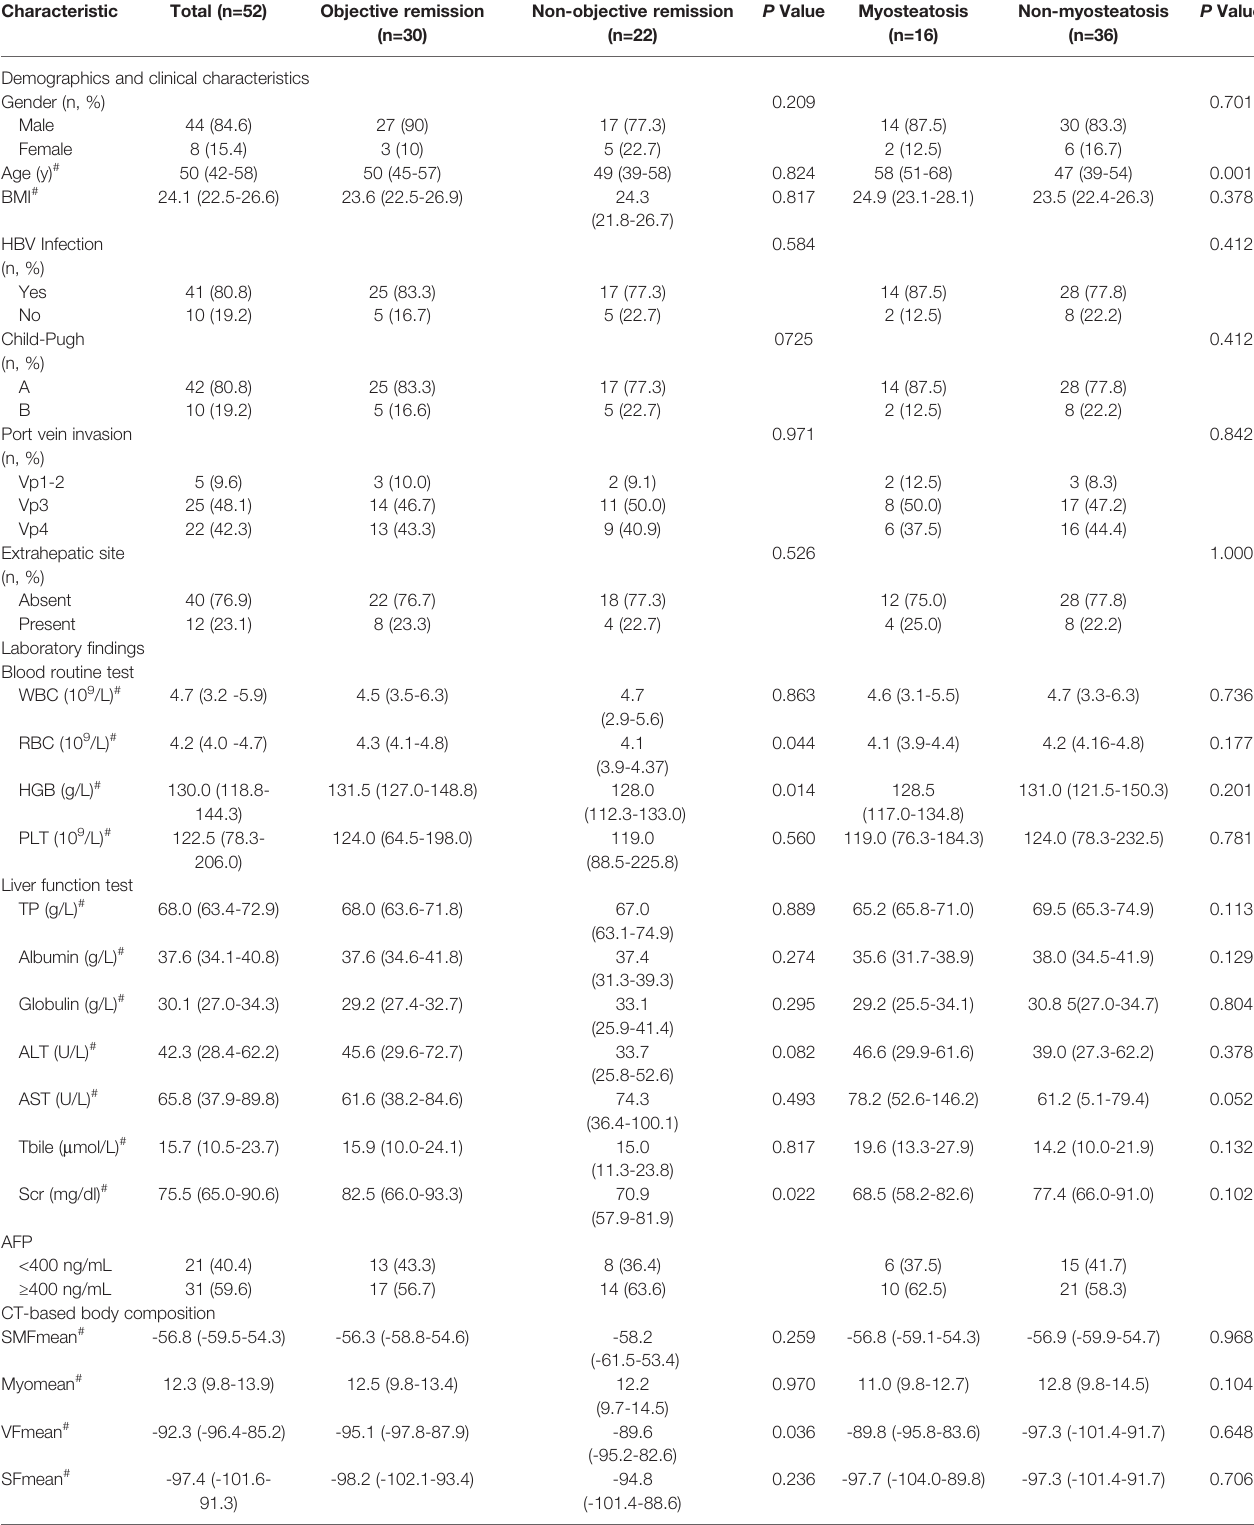
TABLE 1 | Demographic, clinical, laboratory, pathologic and body composition characteristics of 52 HCC patients. Characteristic Total (n=52)